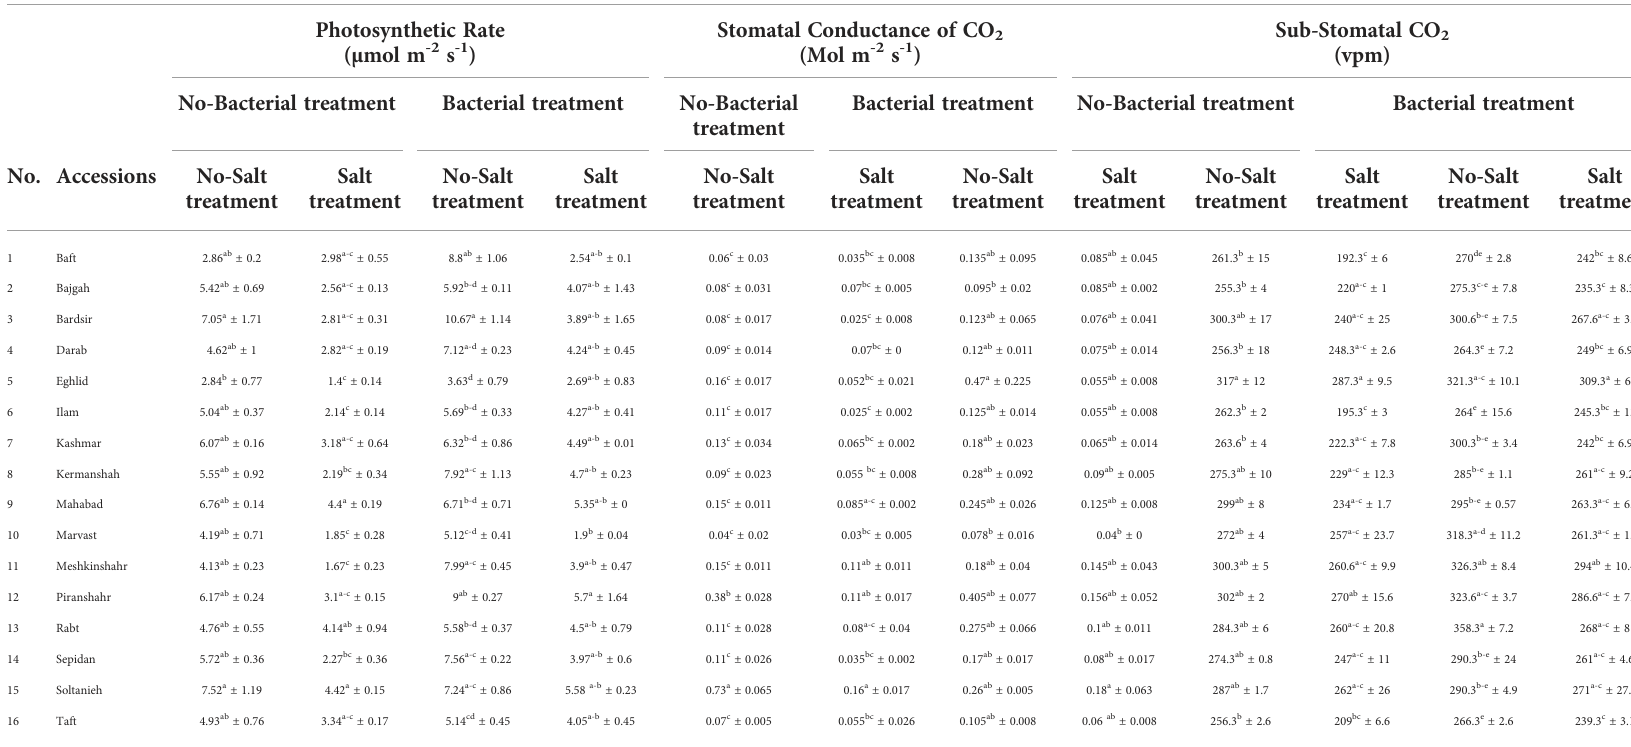
TABLE 3 Effect of Azotobacter and salinity stress interactions on measured photosynthetic parameters of 16 Iranian licorice